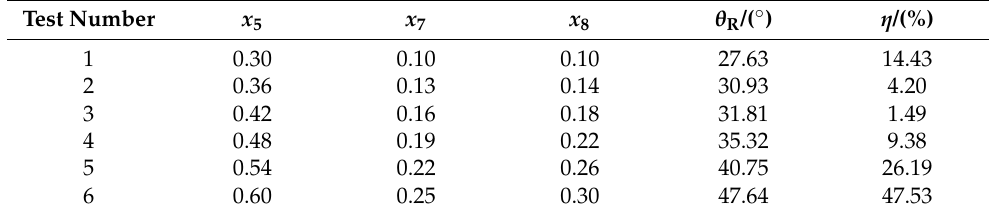
Table 6. The results of the steepest climbing